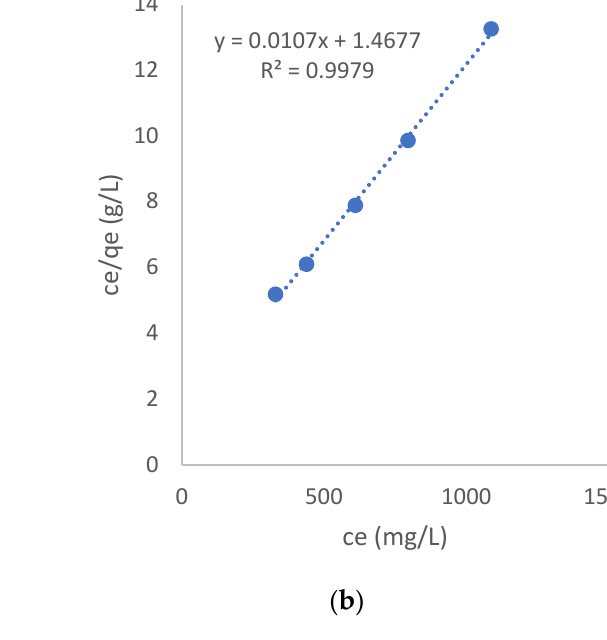
y = 0.0103x + 0.3681 R² = 0.9963